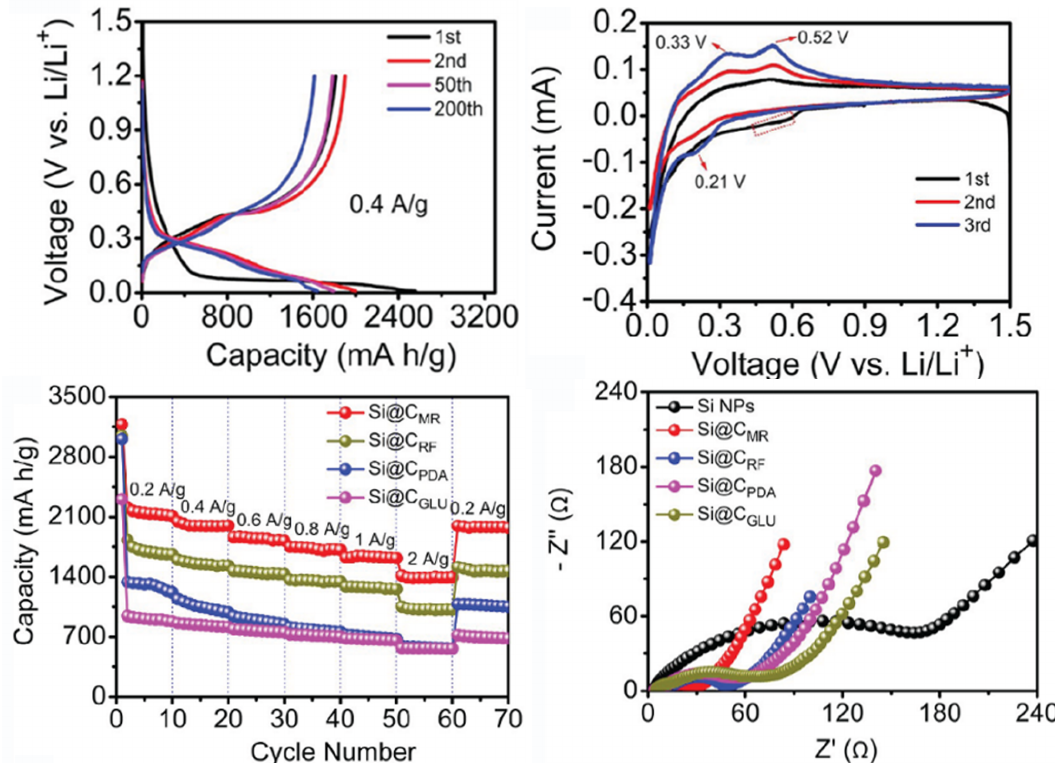
Figure 23. ( Top ) Electrochemical curves for Si/C anode obtained using melamine resin as carbon precursor (Si@C MR ): ( left ) Charge/discharge curves and ( right ) cyclic voltammetry curves. ( Bottom ) Electrochemical curves for Si/C anodes obtained via distinct carbon precursors: ( left ) rate capability and ( right ) Nyquist plots. Reproduced with permission